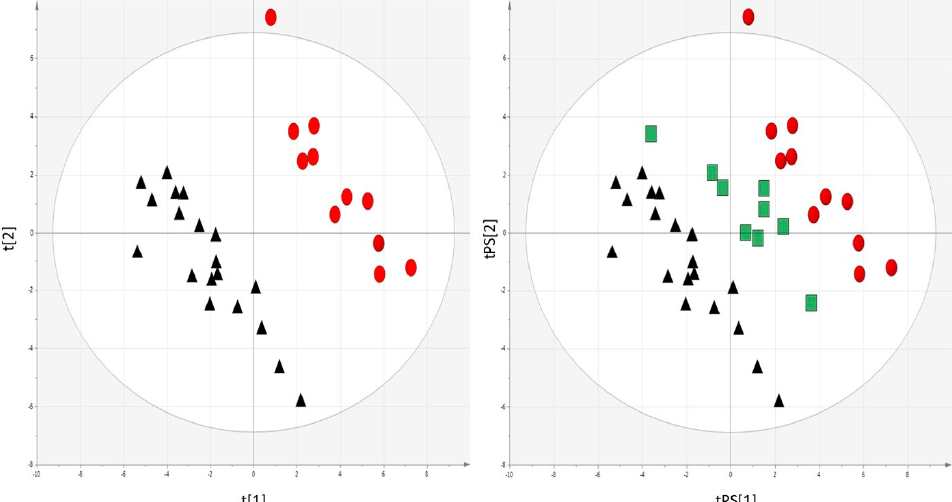
Figure 2. PLS-DA plots demonstrating the differences in the metabolome of the examined groups ( ▲ —patients before the surgery, ● —one month after and quicker remission, ■ —one month and slower remission). The left panel shows all patients clustered together before surgery and separated patients with quicker diabetes remission whose metabolic profiles differ after one-month post-surgery. A prediction of patients with slower remission by PLS-DA model built based on patients before and one-month post-surgery placed slower remission group exactly between the other groups (right panel). R 2 = 0.947, Q 2 = 0.434; Pareto Scaling, Log transformed data.